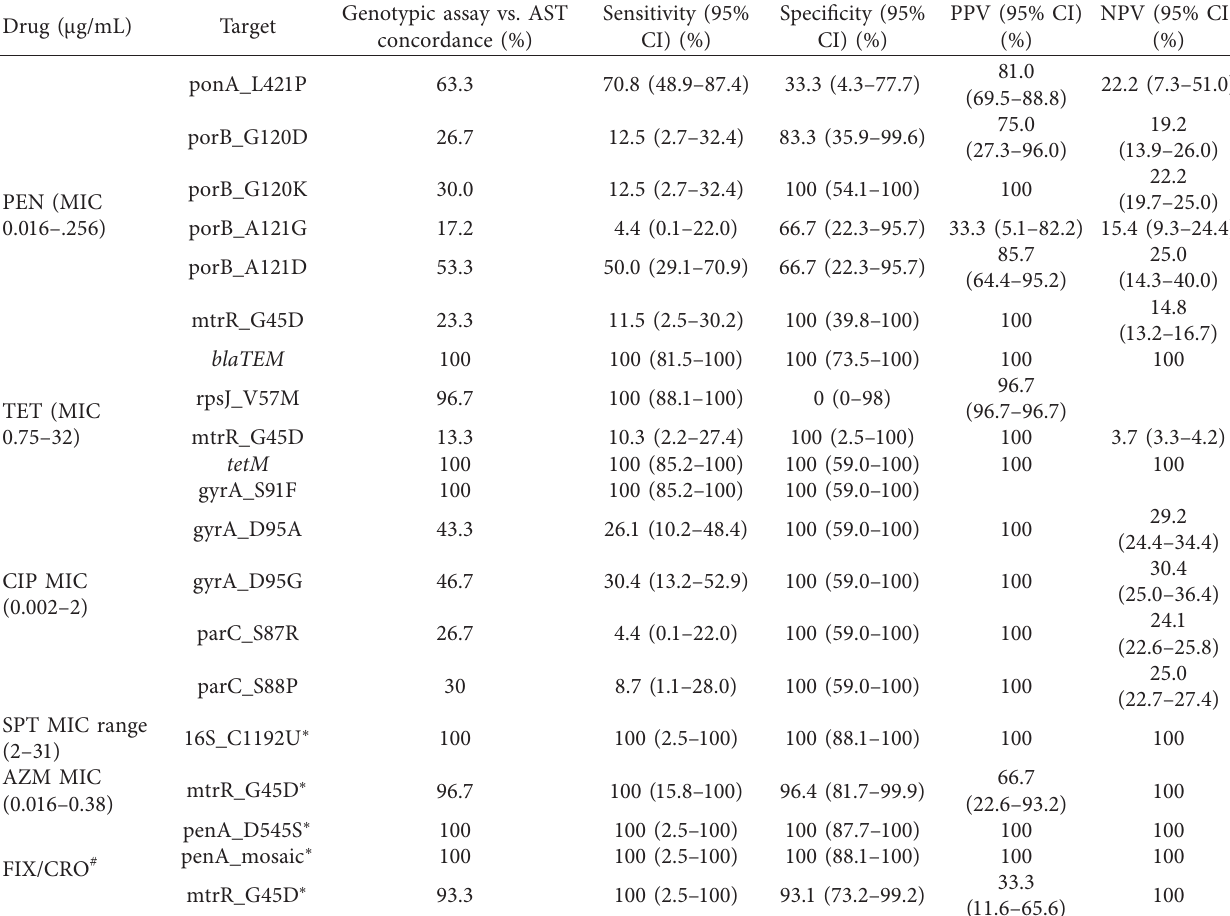
Table 3: Performance characteristics of real-time PCR and high-resolution melt assay compared to phenotypic AST (gold standard) to predict antimicrobial resistance in Neisseria gonorrhoeae clinical isolates and control strains. Drug ( µ